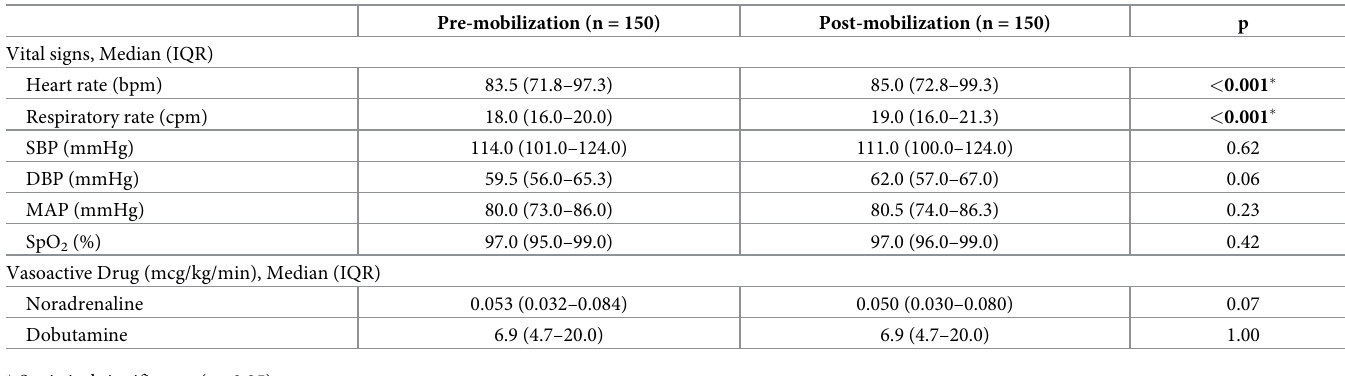
Table 4. Comparison of vital signs and vasoactive drug dosage pre and post early mobilization.